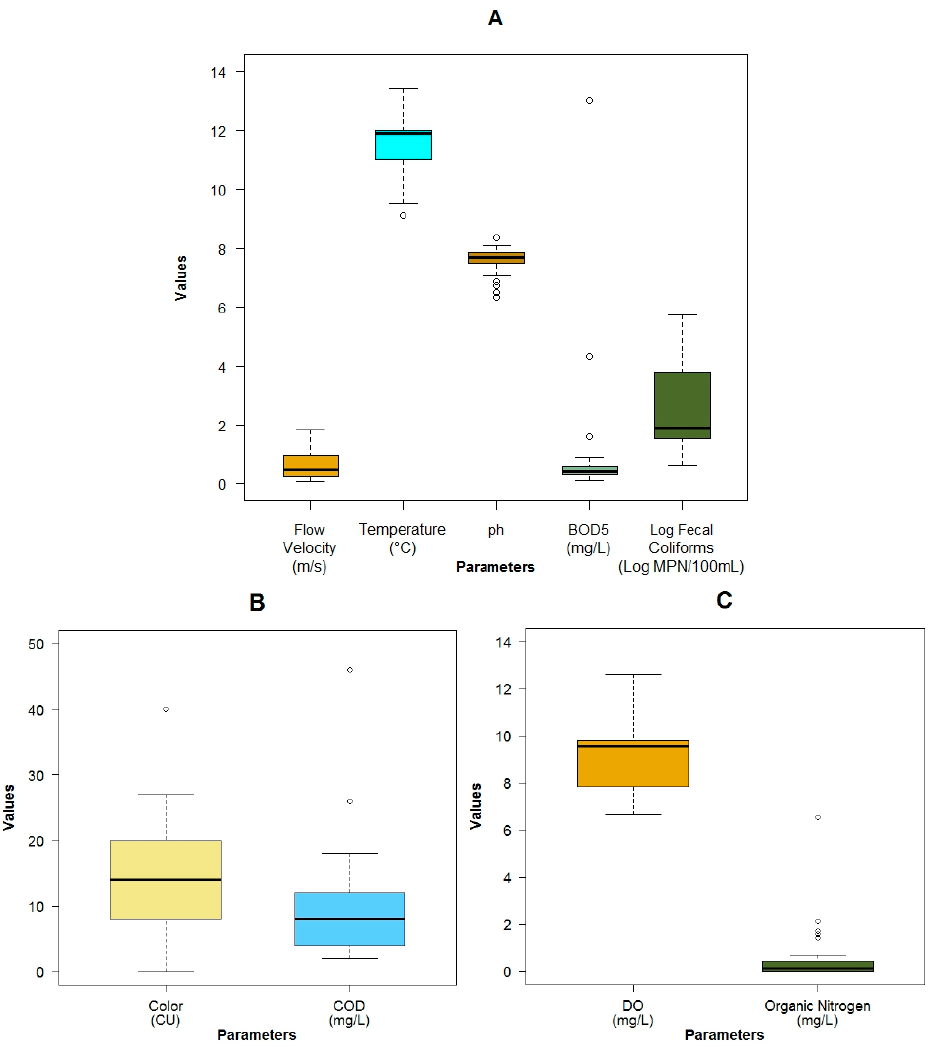
Figure A3. Boxplots of the physicochemical parameters: ( A ) Flow Velocity, Water Temperature, pH, BOD 5 , Log Fecal Coliforms; ( B ) True color and COD; ( C ) Dissolved Oxygen (DO) and Organic Nitrogen.